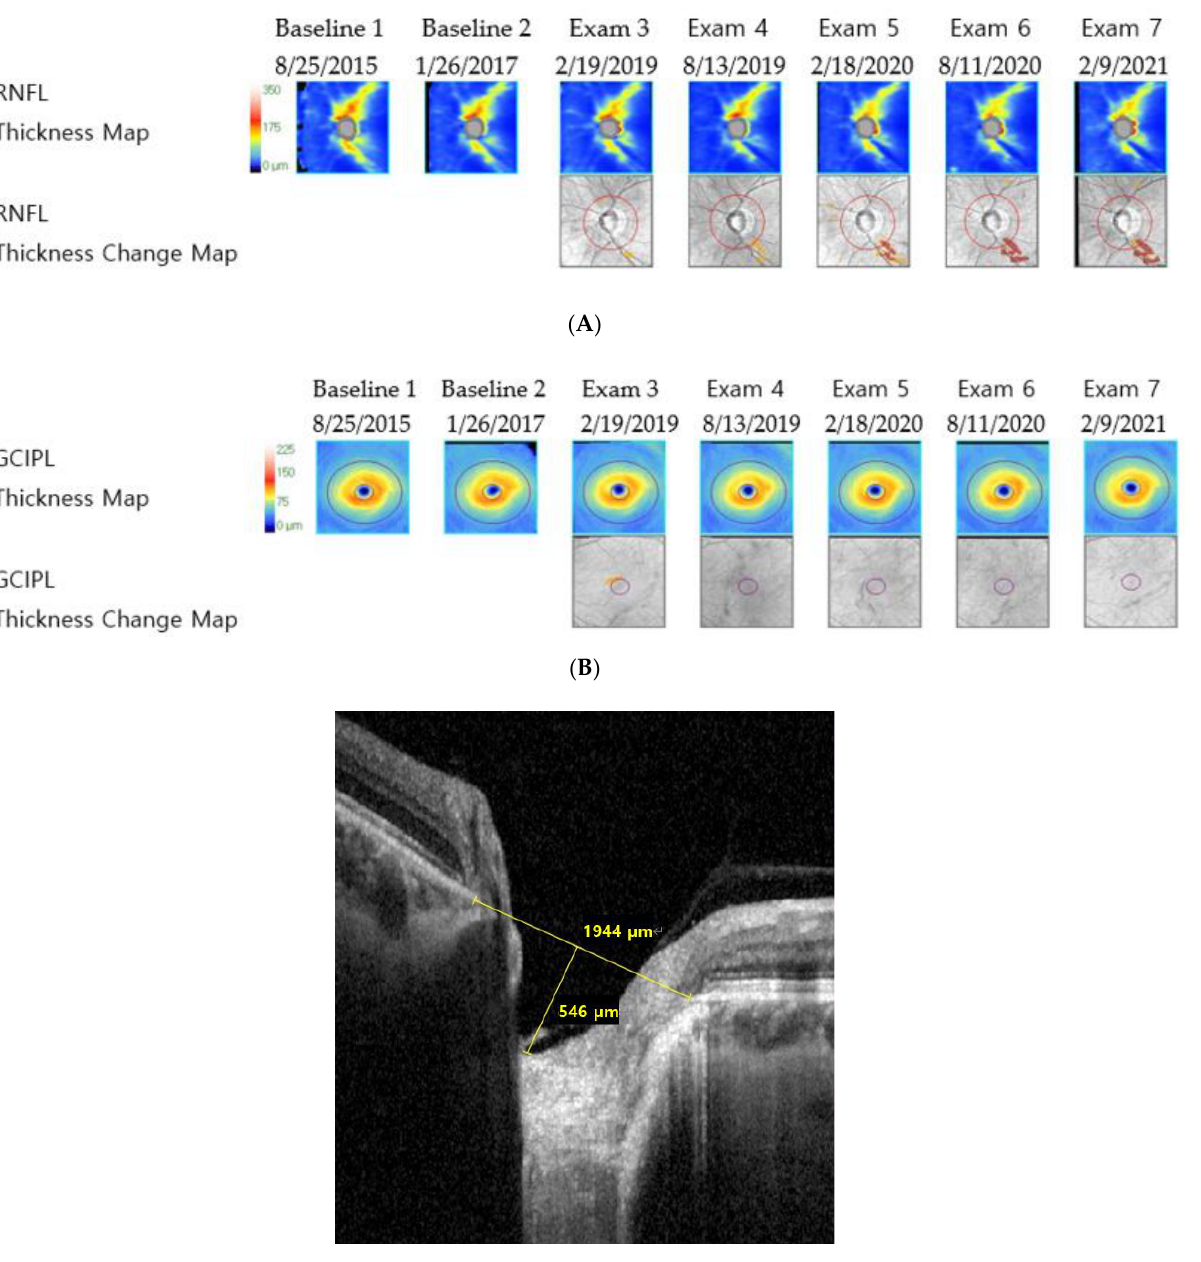
Figure 1. Representative images of a patient with primary open-angle glaucoma from the retinal nerve fiber layer-dominant progression group (mean intraocular pressure with Goldmann tonometry: 17.33 mmHg, axial length: 22.66 mm, visual field mean deviation: − 4.3 dB). ( A ) Retinal nerve fiber layer deviation and thickness-guided progression analysis from Cirrus optical coherence tomography shows progressive retinal nerve fiber layer thinning, ( B ) ganglion cell – inner plexiform layer deviation and thickness-guided progression analysis from the Cirrus optical coherence tomography shows no progression, and ( C ) infrared image of lamina cribrosa from Spectralis optical coherence tomography shows large lamina cribrosa curvature index.